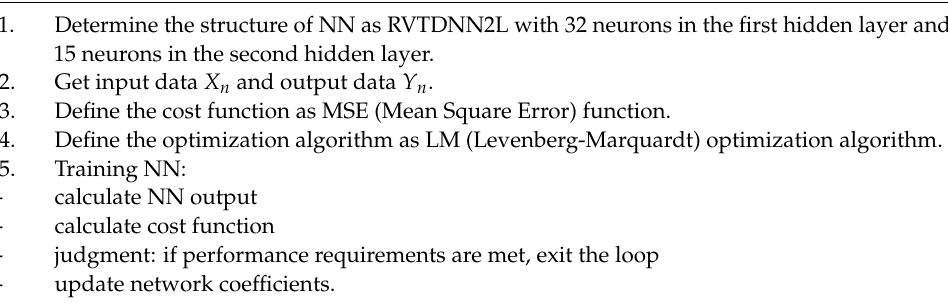
Algorithm 1: NN learning algorithm for PA